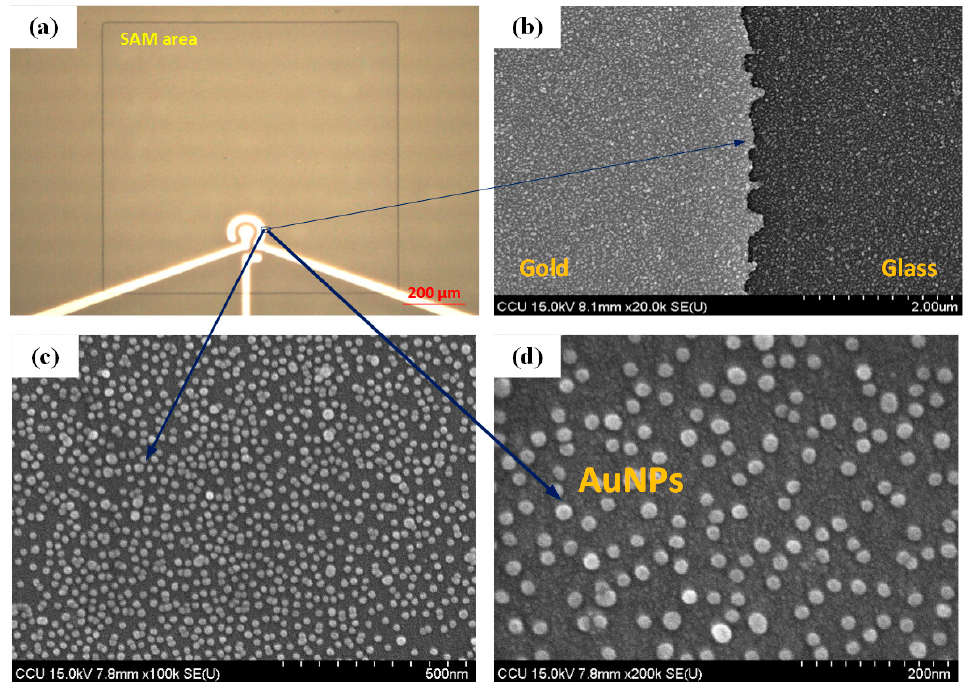
Figure 3. ( a ) A SAM area at the sensing electrodes after a fabrication process of spin coating photoresist, exposure, and development; ( b – d ) Scanning electron microscope (SEM) images of the self-assembled monolayer of AuNPs on the gold-glass substrate with the AuNPs concentration of 179 ppm at the magnifications of 20,000 times, 100,000 times, and 200,000 times, respectively.